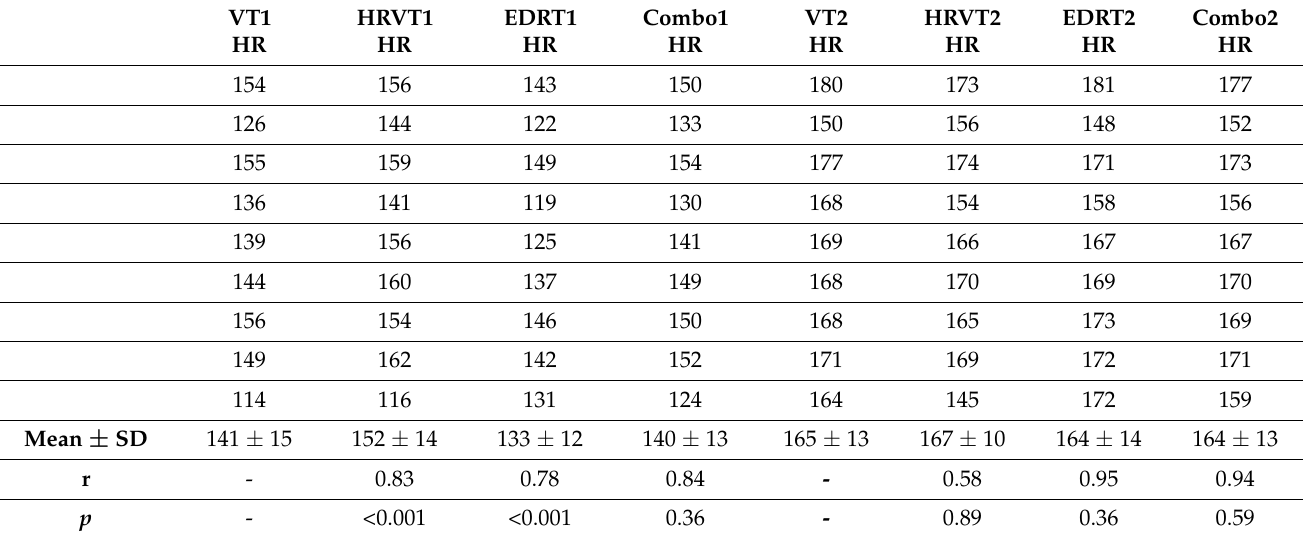
Figure 2. Linear regression of HR for VT1 vs. HRVT1 ( A ), VT2 vs. HRVT2 ( B ), VT1 vs. EDRT1 ( C ), VT2 vs. EDRT2 ( D ), VT1 vs. Combo1 ( E ), and VT2 vs. Combo2 ( F ) with standard error of estimate (SEE), Pearson’s r, and total tests compared (N). Combo values based on only a single threshold modality (EDRT) are represented as “×”.